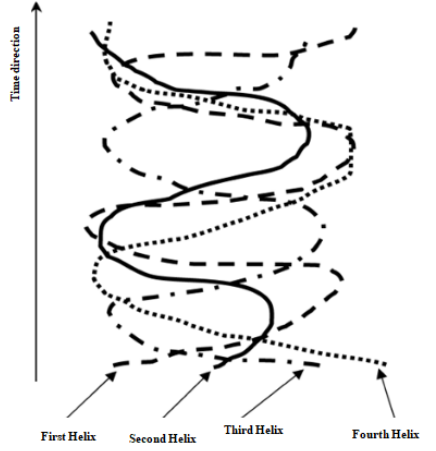
Figure 3. The quadruple helix innovation model (source: created by authors with a base on Etzkowitz & Leydesdorff (2000), Carayannis & Campbell